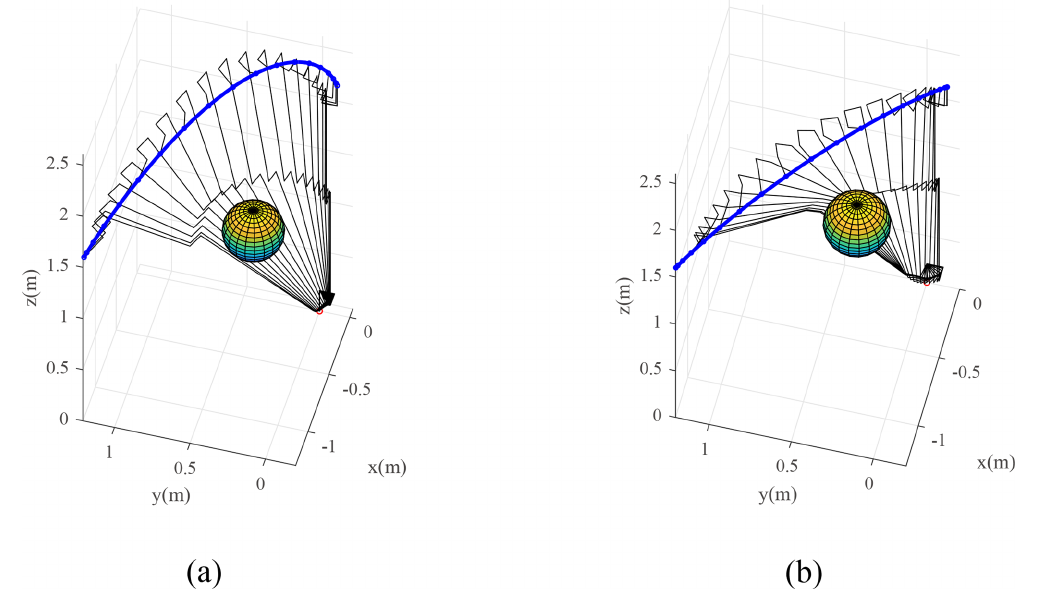
Figure 9. The configuration change of the manipulator and its geometric relationship with the obstacle. (a) Solution 2. (b) Solution 3.